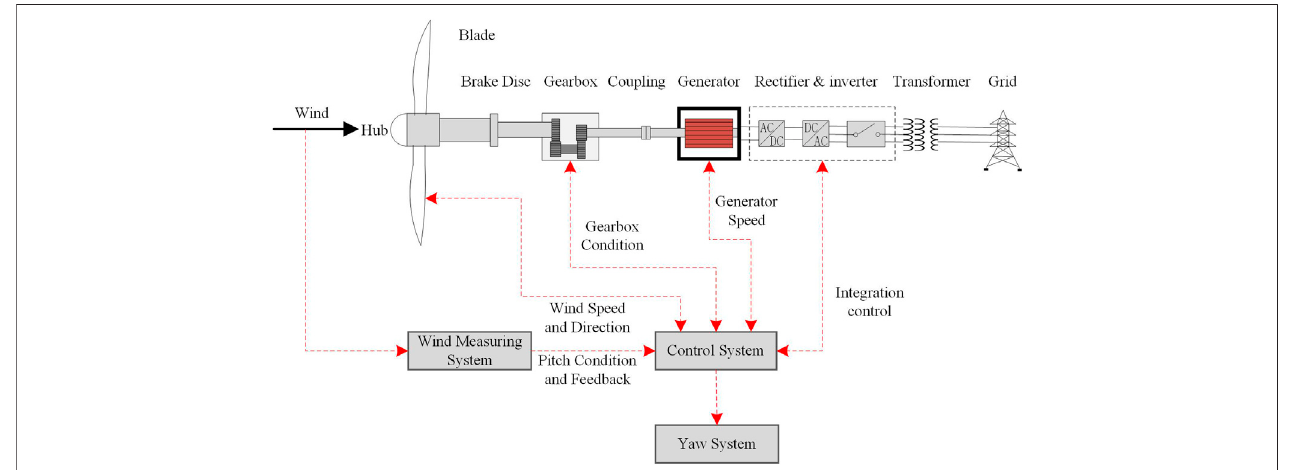
FIGURE 3 | Main structure of